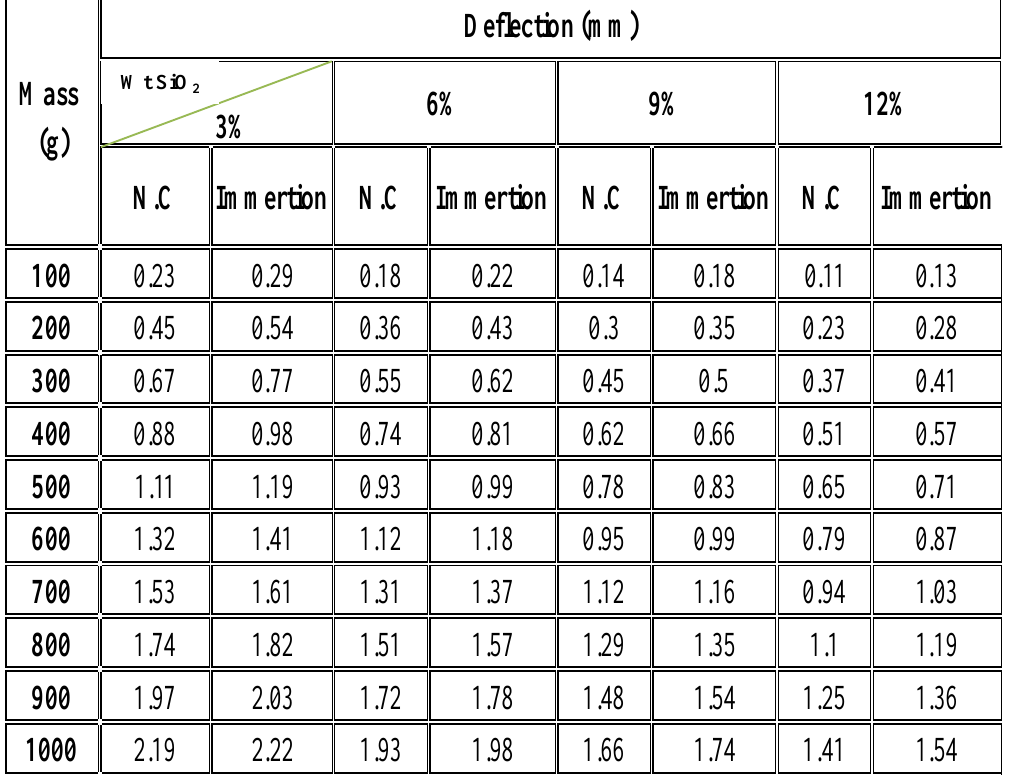
SO acid for 10 2 4